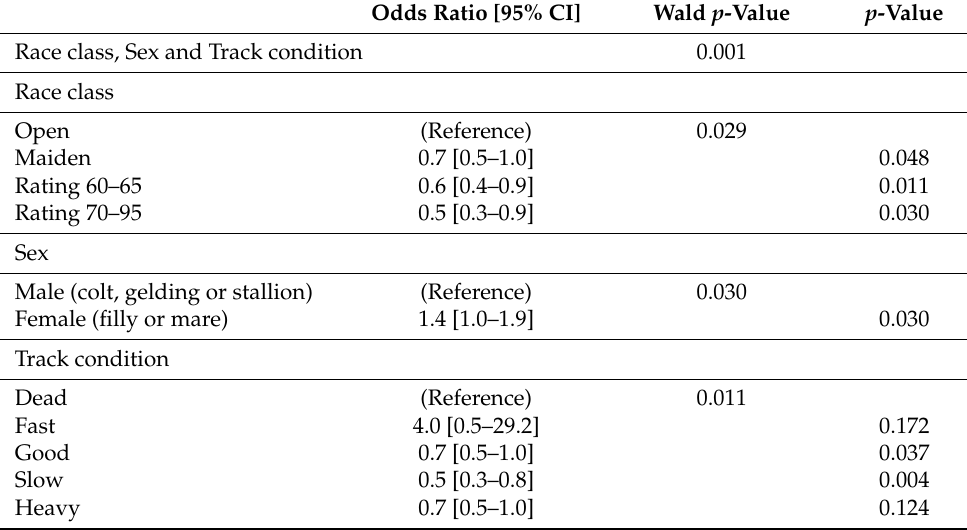
Table 3. Multivariable odds ratios and 95% confidence of an incident occurring with the effects of race class, sex and track condition.